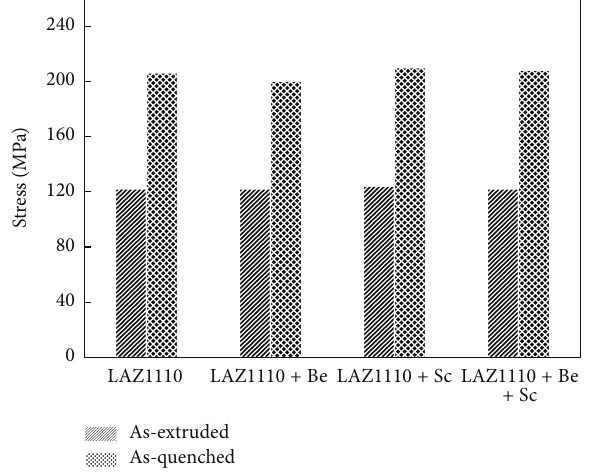
Figure 6: Tensile strengths solution specimens treated at 400 ∘ C and water quenched